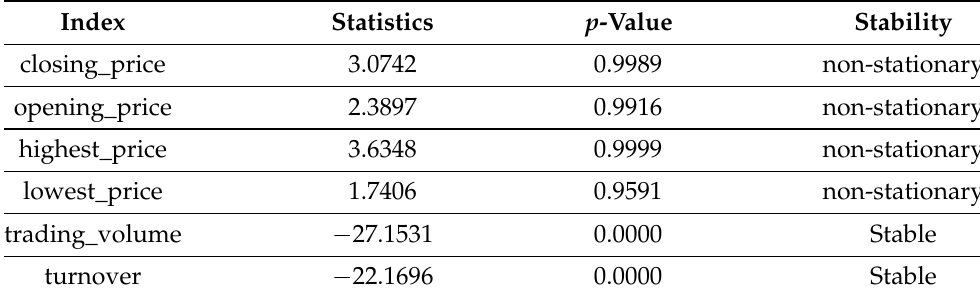
Table 2. Results of the LLC panel unit root test for the variables.